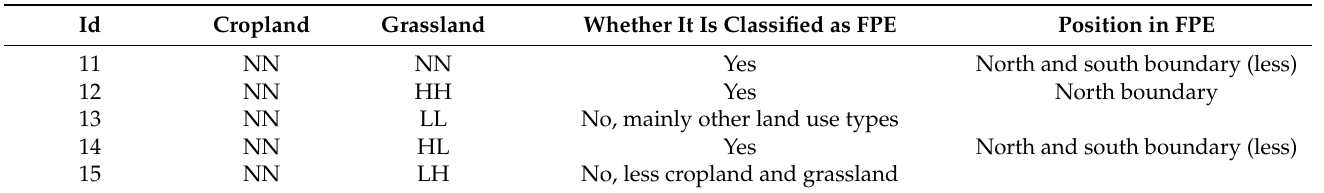
Table 2. Criteria of FPE